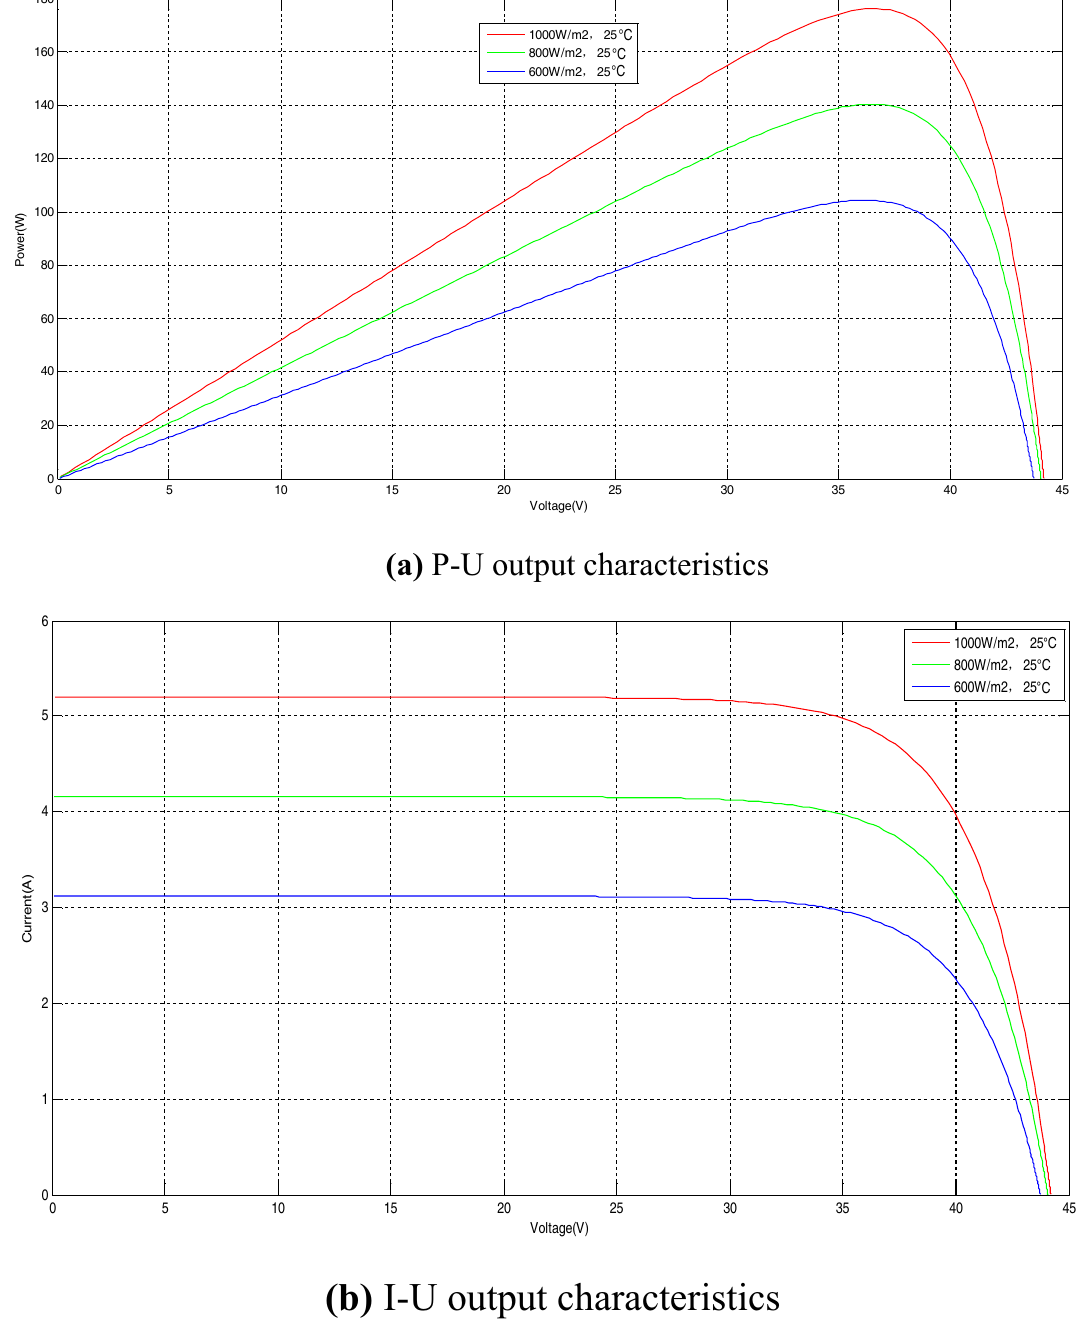
Figure 3. The output characteristics of PV panel when the light intensity